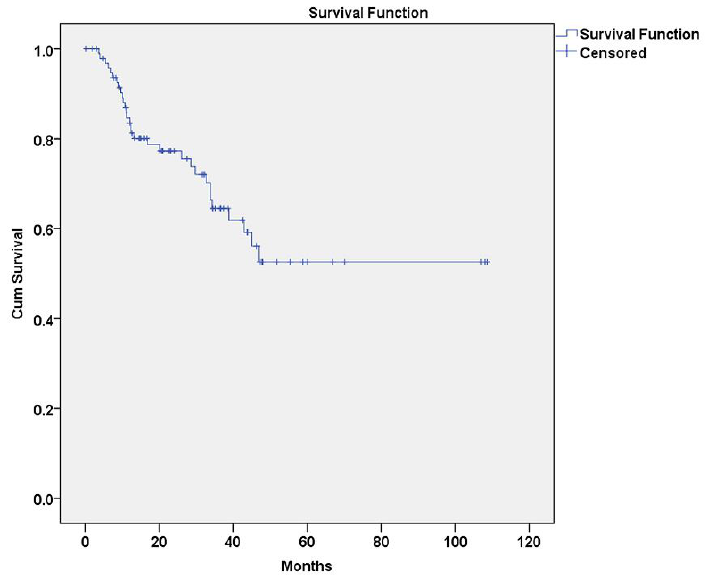
Figure 2. Kaplan–Meier analysis of first recurrence in oral leukoplakia (OL) lesions ( n =